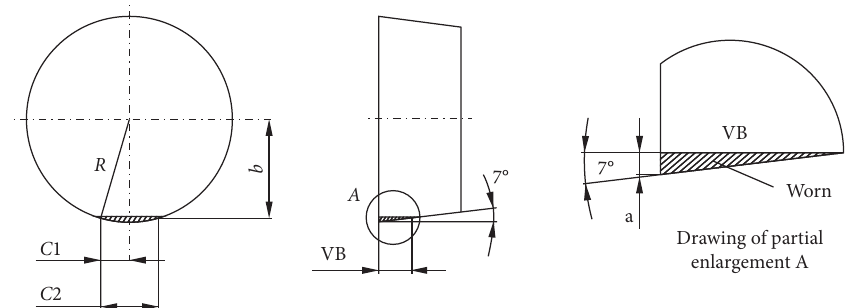
Figure 4: Effects of tool wear on surface roughness.